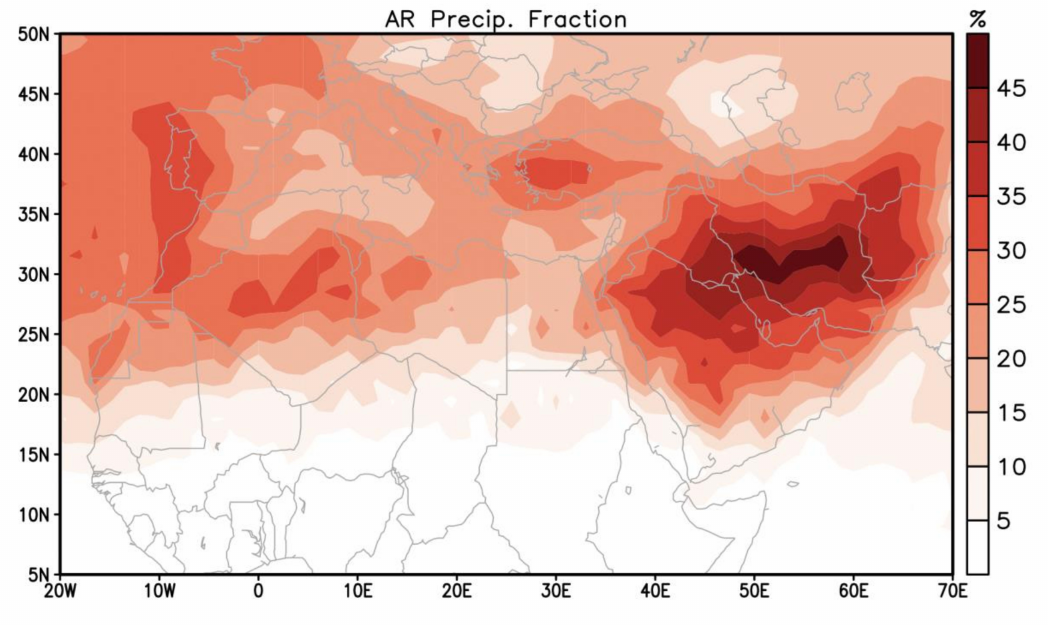
Figure 3. A representation of the fraction of annual precipitation that is associated with atmospheric rivers. The darker shades of red contours indicate areas where ARs account for more than 30% of the total rainfall, with central Iran having nearly half of its precipitation coming from